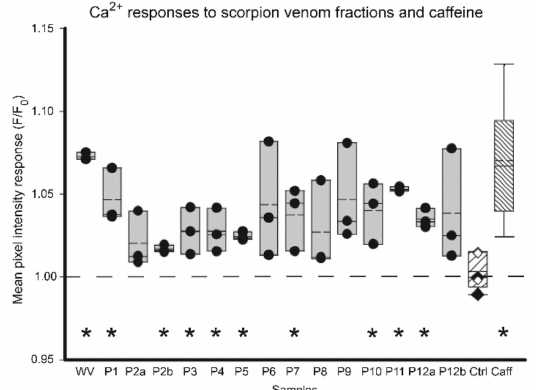
Figure 6. Summary of Ca 2 + responses to Australian scorpion Hormurus waigiensis venom fractions and ca ff eine in GCaMP5G-RyR1-HEK293 cells. Boxplots with overlaid data for responses to whole scorpion venom (WV), 14 SE-FPLC peak samples (see Figure 1B), negative controls, and the 4 mM ca ff eine (Ca ff ) positive control. Negative controls (Ctrl): PBS (black diamonds, n = 3) and DMEM media (white diamonds, n = 2) were combined. All venom tests were performed in triplicate. The ca ff eine data were combined from the 44 experiments. The box plots reflect 25% and 75% percentiles, with median shown as a solid line and mean shown as a dashed line; 95% percentile are shown as feather bars. * indicates a significant Ca 2 + response ( p < 0.05), as determined by one-sample t -tests (single-tailed).